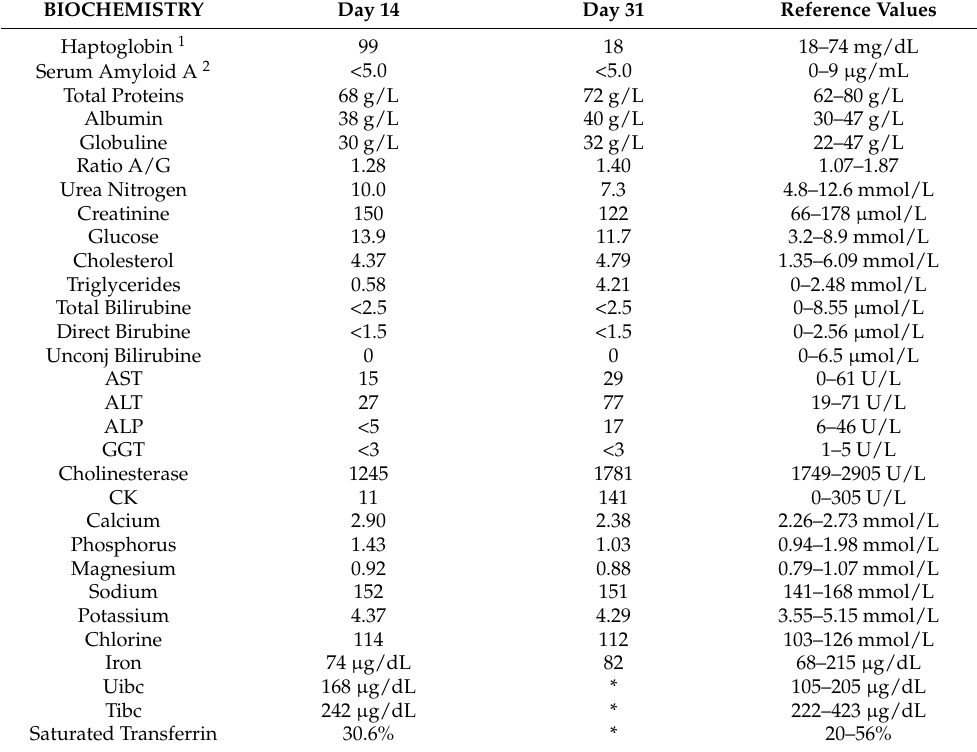
Table 2. Biochemistry performed on Days 14 and 31, respectively. Analyses were performed on serum through the Cobas c501 clinical chemistry analyser with a related kit (Roche Diagnostics International AG, Rotkreuz, Switzerland) at the SCS3 Laboratory Medicine of the